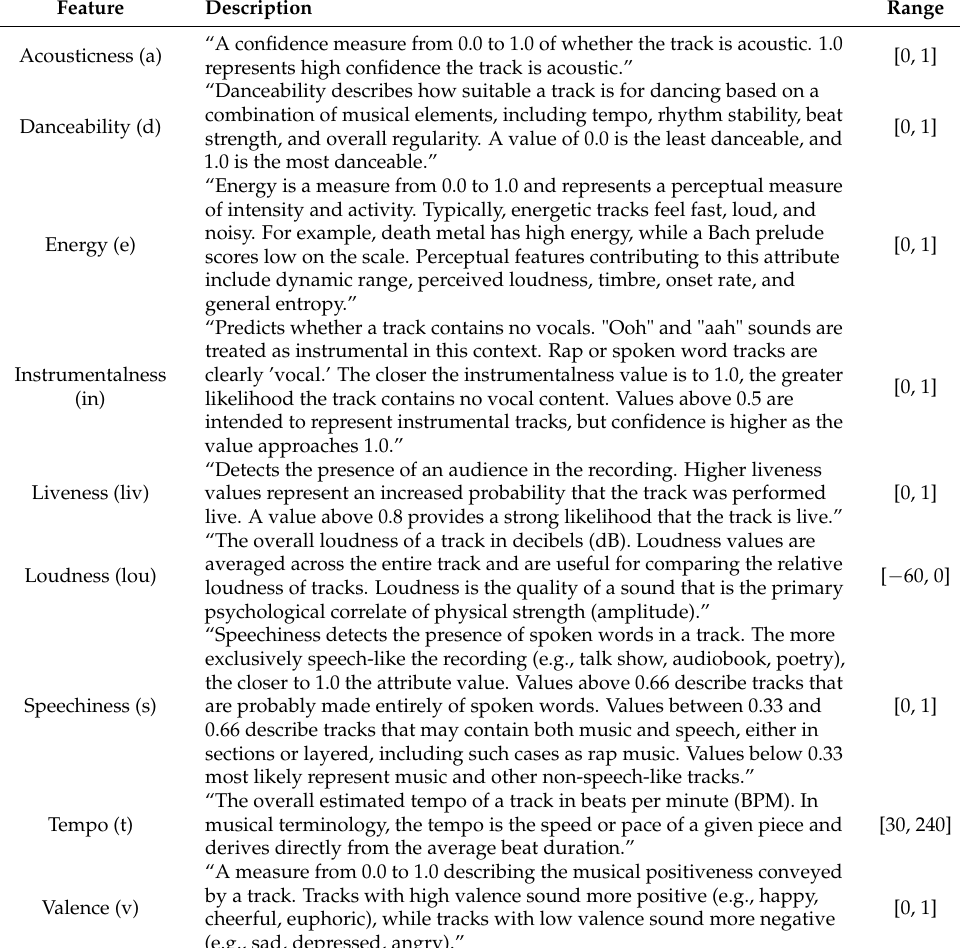
Table 2. Audio features for a music track provided by the Spotify